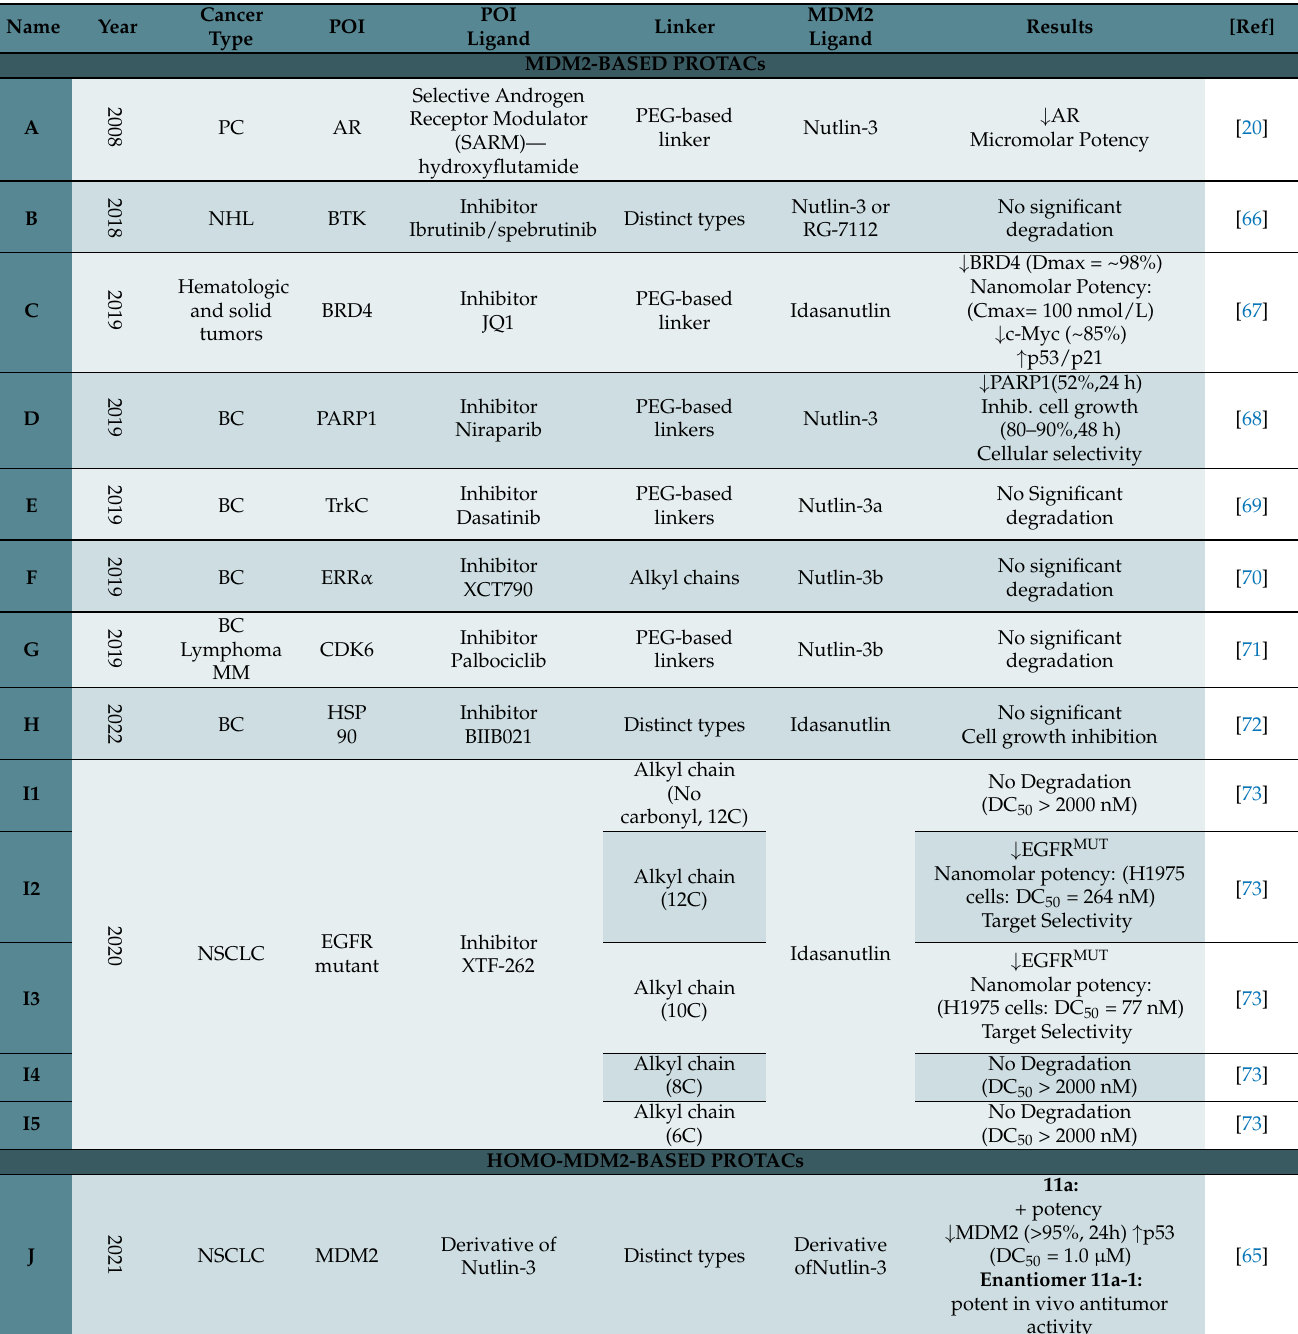
Table 3. MDM2-based PROTACs. Summary table of all MDM2-based PROTACs created to date for the treatment of several types of